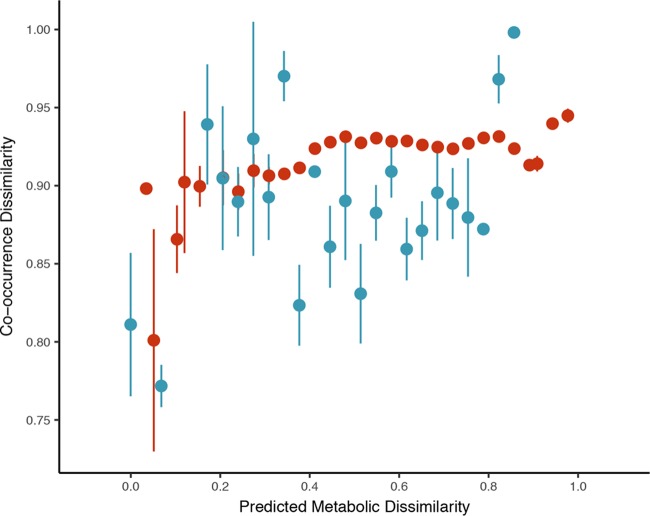
Relationships between OTU cooccurrence (Jaccard distances of rarefied OTU counts) and predicted metabolic dissimilarity (Jaccard distances between OTU seed sets) matrices for host-enriched taxa. To avoid the overplotting associated with the visualization of the more than 1.5 × 105 pairwise comparisons, we visualized the relationships between matrices using binned scatterplots of mean Jaccard distances ± 2 SEM. Colors are the same as in Fig. 1: blue, leaves; and red, roots. Relationship between binned leaf-enriched OTU Jaccard distance and competitive dissimilarity matrices are highly variable and nonsignificant (P = 0.141). However, a significant positive relationship for root taxa (P = 0.008) is visible and consistent with a habitat-filtering community assembly mechanism (61).